Question: Express in one sentence what the figure is showing.
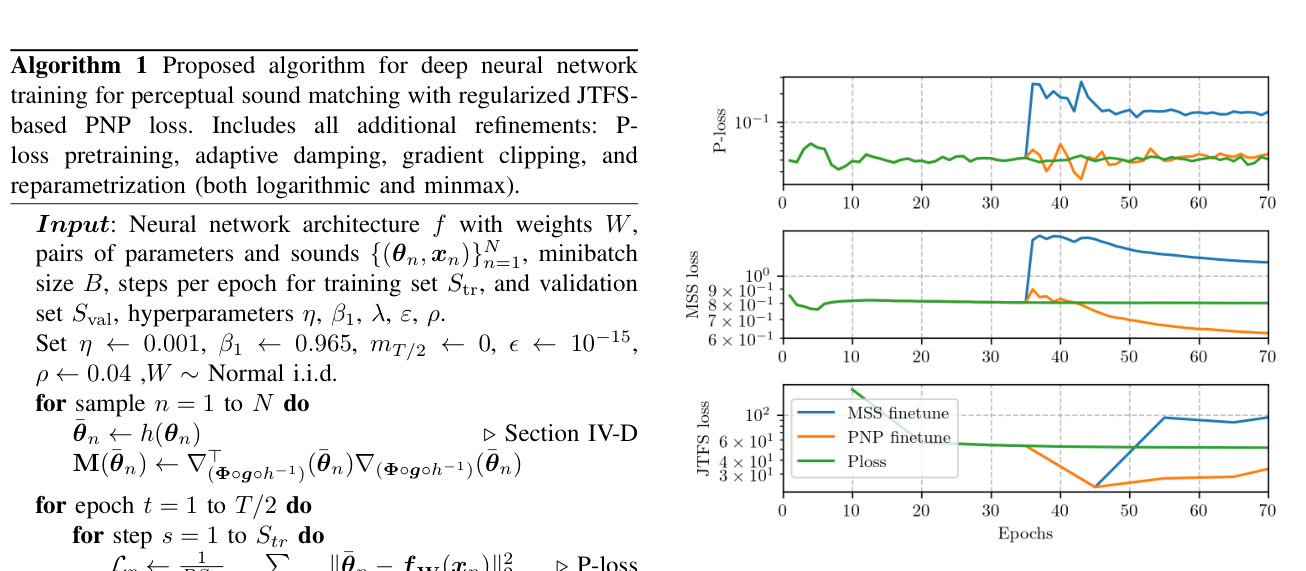
Answer: Learning dynamics of P-loss. Pretraining with P-loss followed by finetuning with JTFS-based PNP loss and MSS loss. The curves show progression of three measures (average P-loss, MSS, and JTFS distance on validation set) over the course of 70 epochs training time. P-loss converges rapidly yet reaches plateau on all metrics. JTFS-based PNP finetuning keeps improving upon the two perceptual metrics without deteriorating on P-loss metrics. On the contrary, MSS finetuning fails to converge to an optimal solution after a spike in metrics due to a re-initialized learning rate.